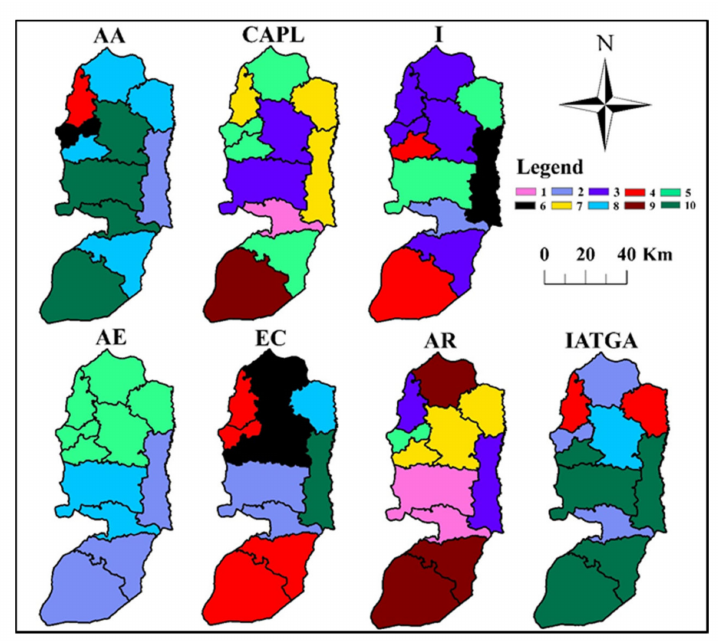
Figure 3. The score rasters of the 12 AWP criteria for the West Bank case study.